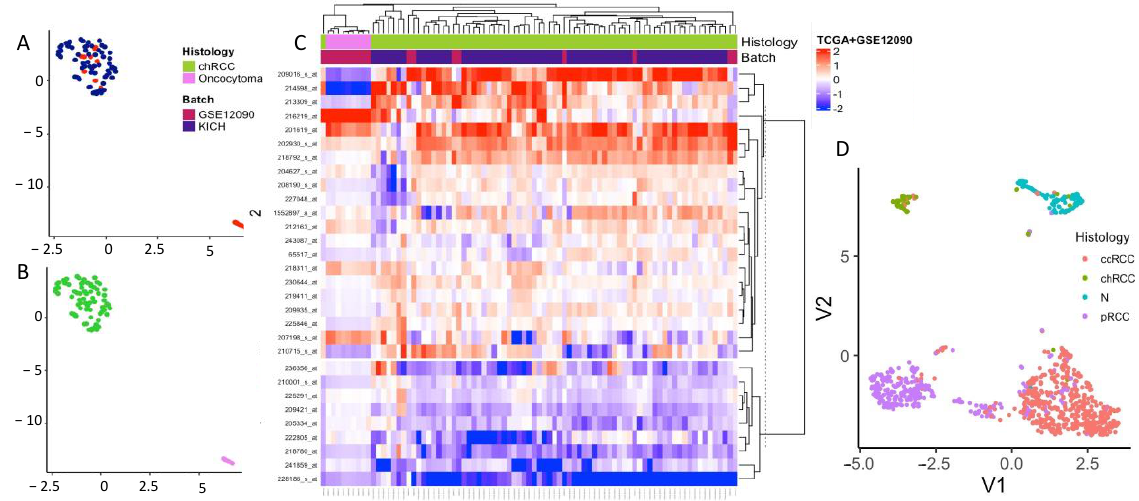
Figure 6. COGS validation on RNA-Seq (TCGA-KICH) and micro-array dataset (GSE12090): ( A ) two-dimensional embedding plot with UMAP using COGS showing no batch effect between the studies in the validation dataset; ( B ) sample plot with histology annotation shows distinct clusters for chRCC (n = 74) and RO (n = 9) with COGS; ( C ) unsupervised hierarchical clustering with COGS for validation dataset ( D ) UMAP of TCGA renal cohort showing distinct cluster for chRCC samples (lime green) for COGS.